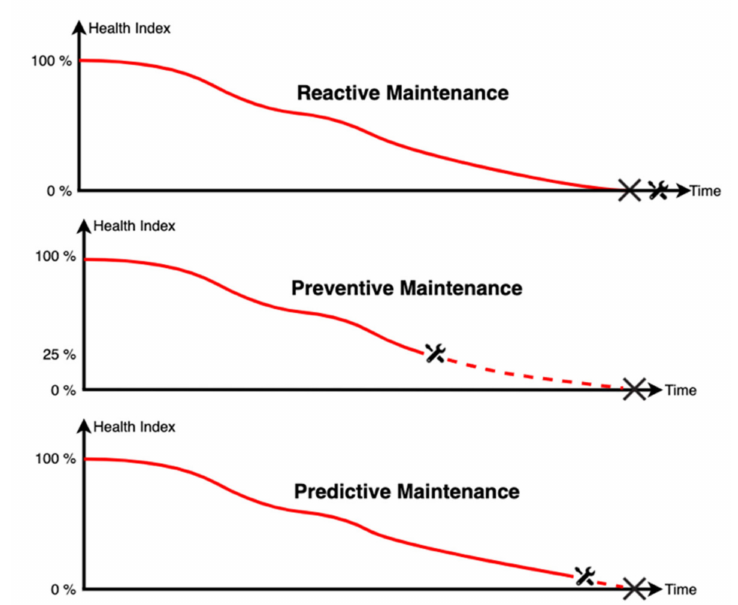
Figure 1. Example sketch of the maintenance strategies: reactive maintenance, where maintenance is applied after a failure occurred; preventive maintenance, where maintenance is always applied when the health index reaches 25%; predictive maintenance, where maintenance is done directly before the failure